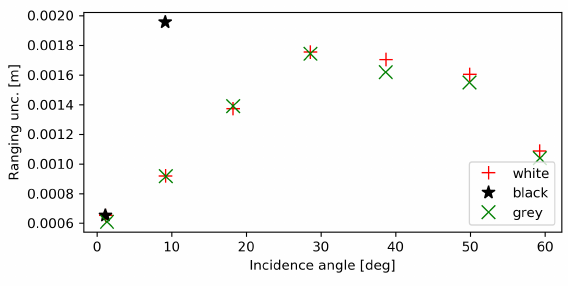
Figure 9. VZ-400 ranging uncertainty vs. incidence angle for a constant range of 60m .